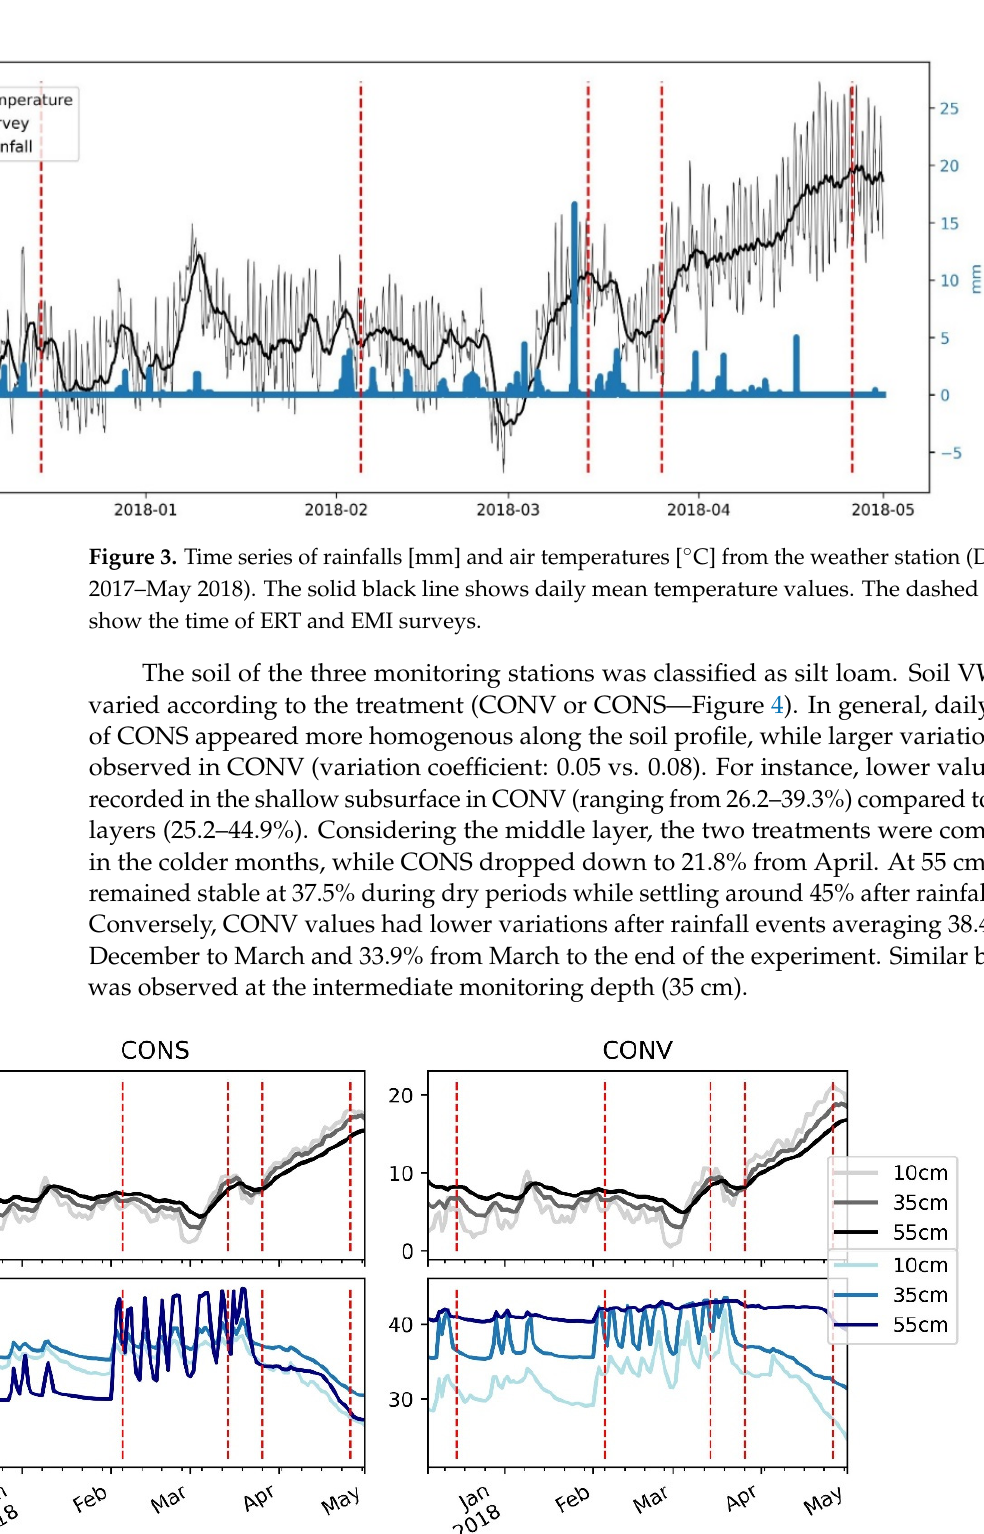
Figure 3. Time series of rainfalls [mm] and air temperatures [°C] from the weather station (Decem- ber 2017–May 2018). The solid black line shows daily mean temperature values. The dashed red lines show the time of ERT and EMI surveys.